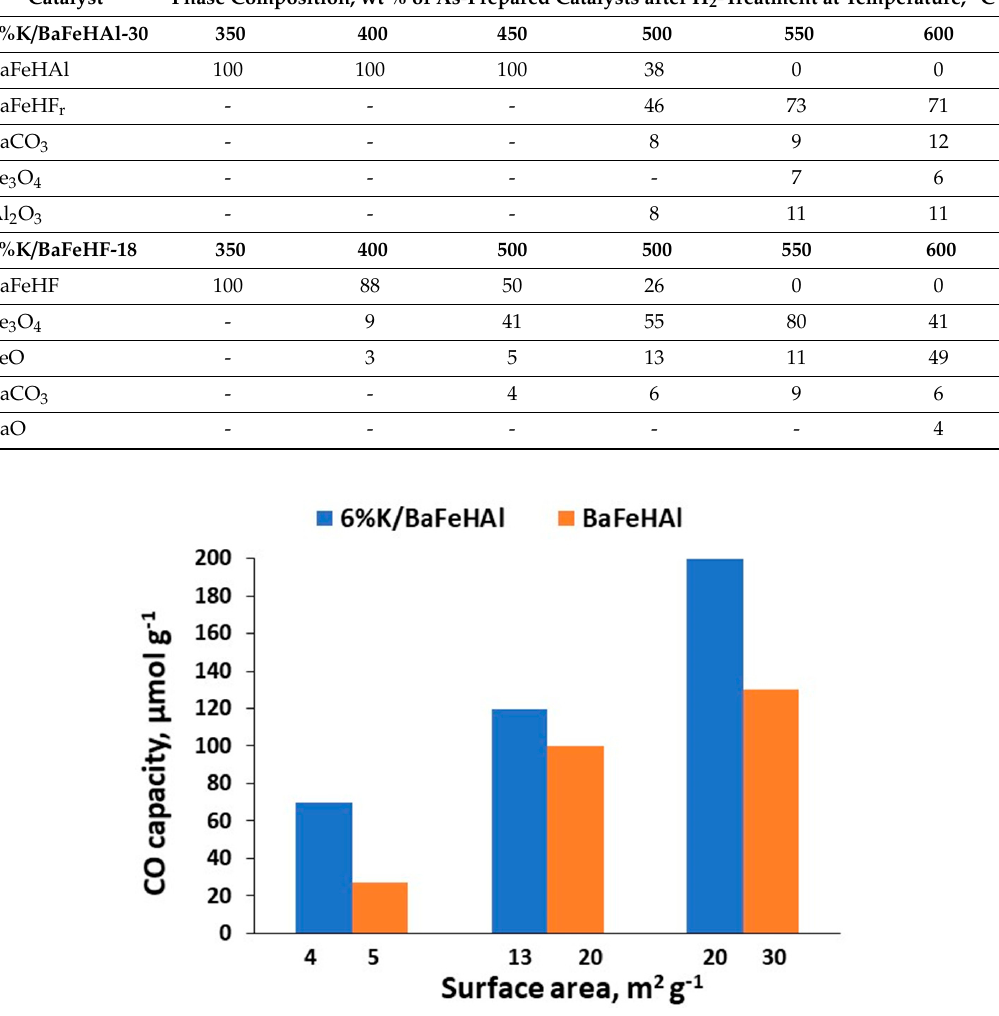
Figure 5. Effect of K-promotion and surface area of BaFeHAl catalyst on the CO capacity at 450 °C.